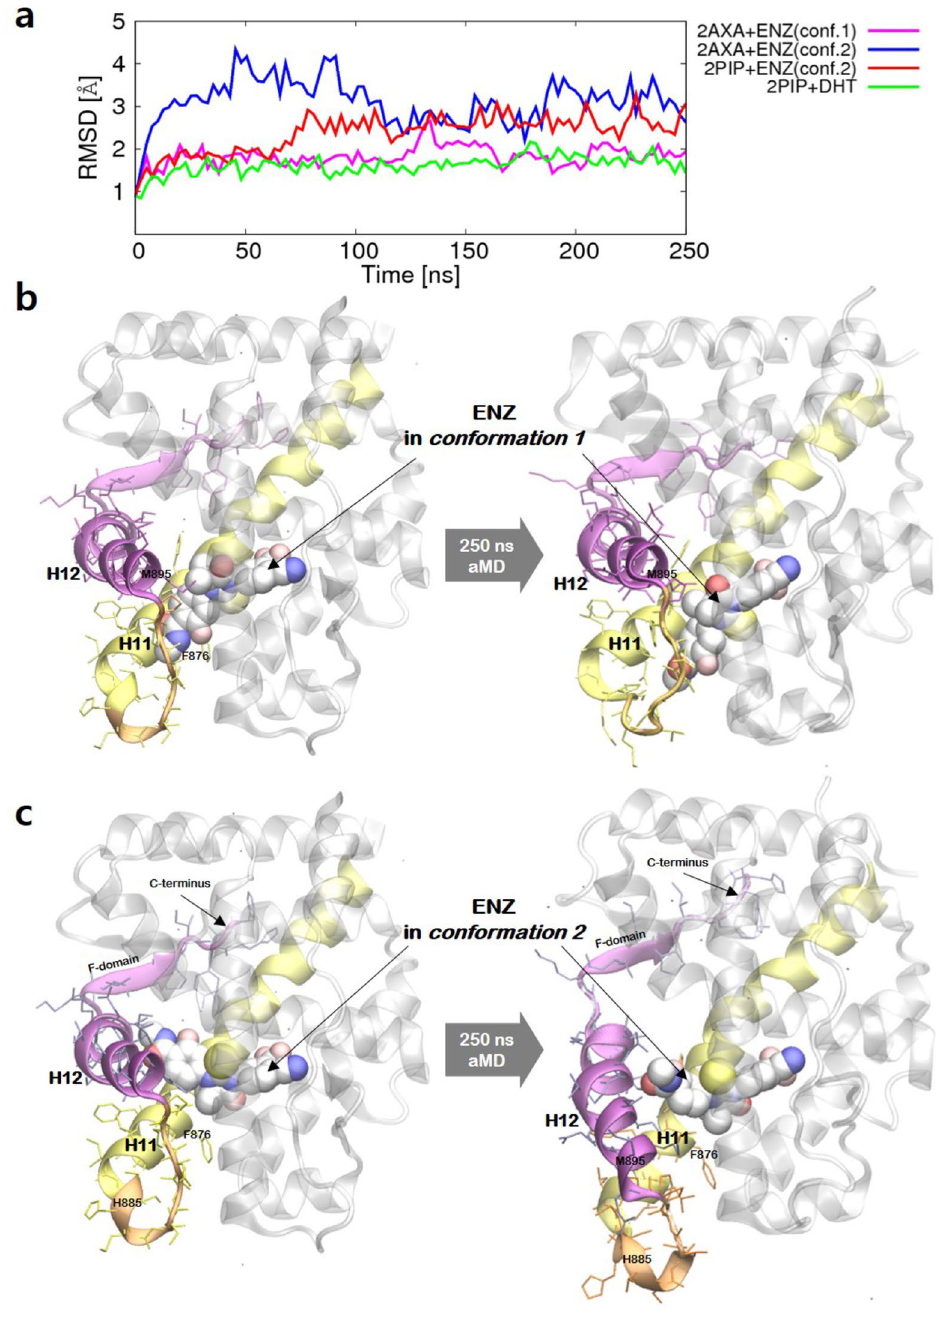
Figure 5. Conformational changes of the wild type AR bound to ENZ during 250 ns aMD simulations. ( a ) The backbone RMSDs of AR-ENZ complexes relative to the initial agonist conformation. The visualizations of initial and 250 ns simulated structures of the wild type AR bound to ENZ in ( b ) conformation 1 and ( c ) conformation 2 . Images were created by using Gnuplot v5.2 57 and VMD v1.9.3 52